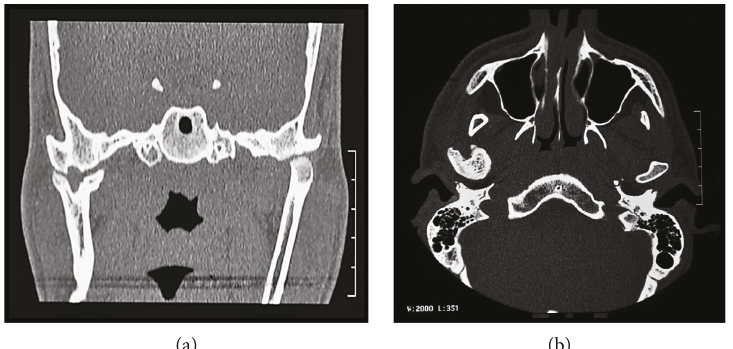
Figure 4: (a) Coronal view of the CT scan emphasizing the bi fi d mandibular condyle in the laterolateral direction. (b) Axial view of the CT scan showing ankylosing mass.